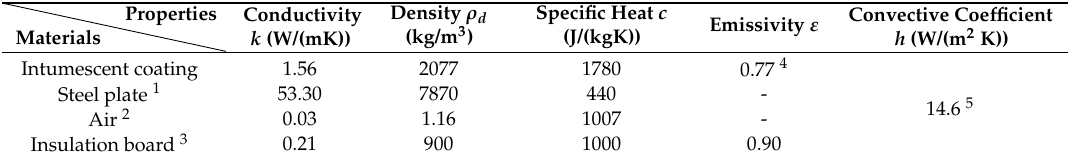
Table 4. Thermo-physical properties of the materials and convective coefficients in cone calorimeter